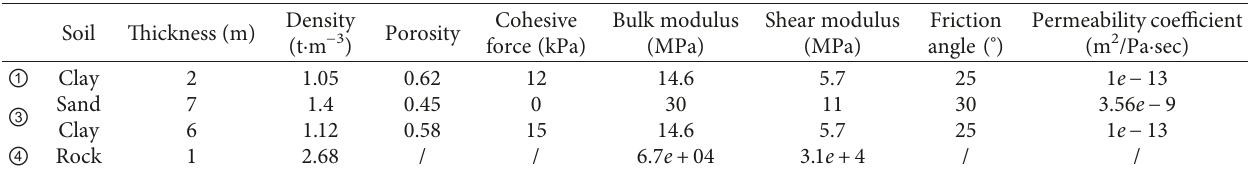
Table 2: The distribution of soil layers and physical and mechanics parameters of the numerical simulation model corresponding to three soil layers.